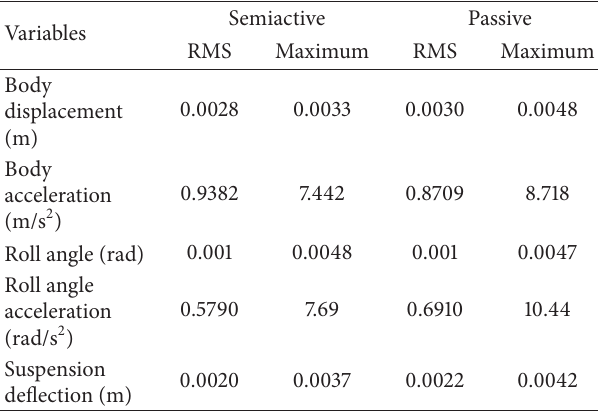
Table 3: Comparison of the performance of semiactive system and passive system for the second